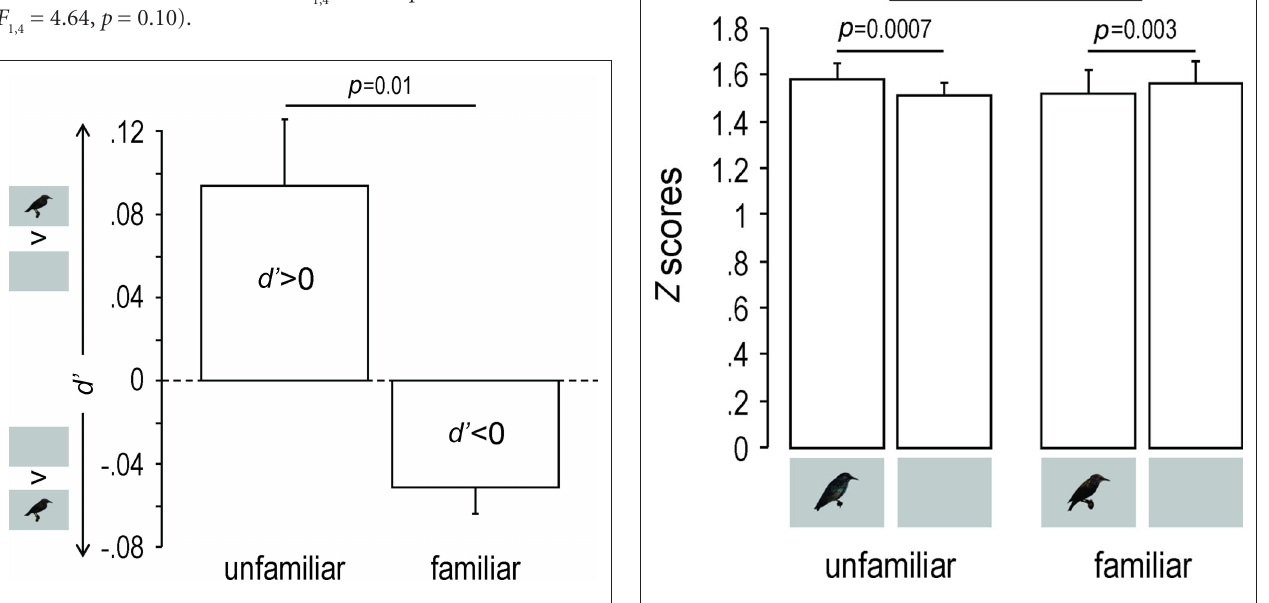
FigurE 4 | response modulation as shown by mean ( + SEM) d ′ values obtained across birds for unfamiliar and familiar stimuli. Only neuronal sites exhibiting a | d ′ | value of 1 or more were taken into account. Small inserts along the y axis indicate whether the acoustic stimuli were presented with (AV condition) or without (A condition) visual stimuli.